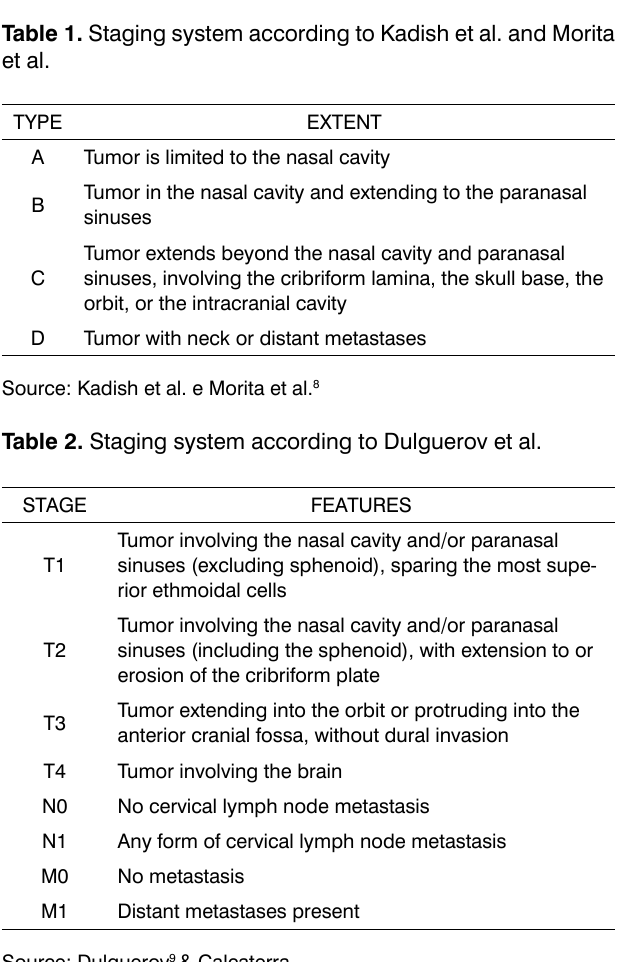
Table 1. Staging system according to Kadish et al. and Morita